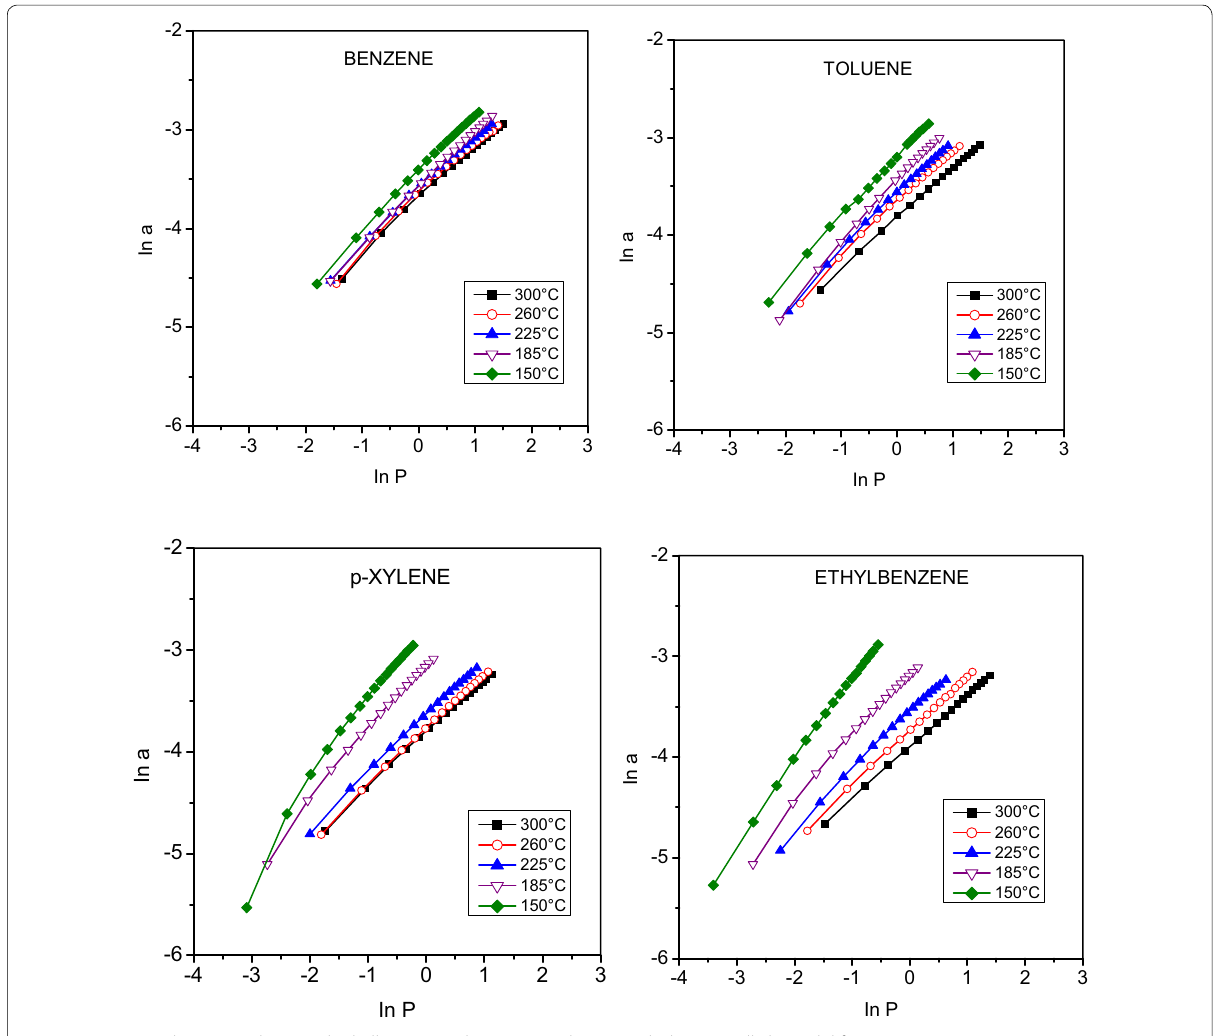
Fig. 6 Benzene, toluene, p ‑xylene, and ethylbenzene adsorption isotherms with the Freundlich model for